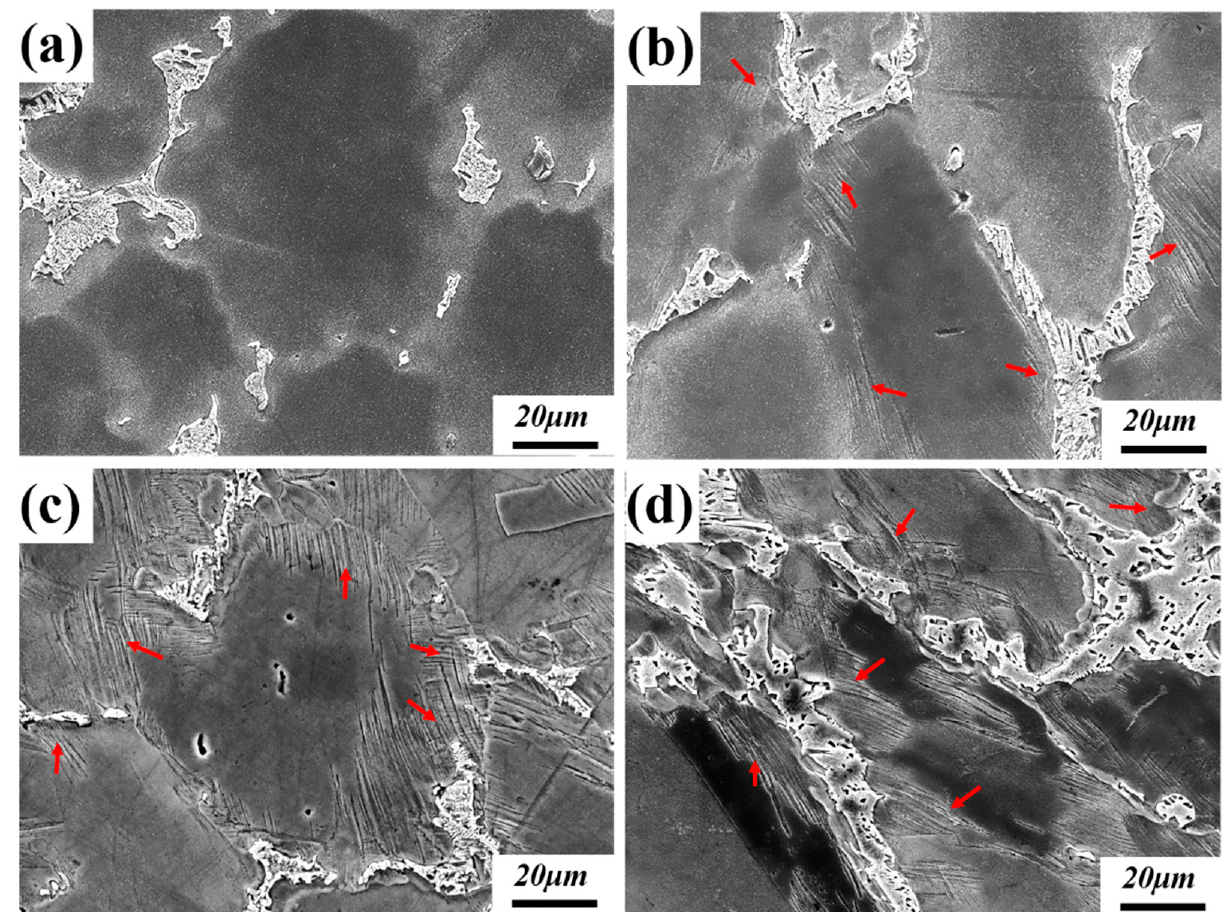
Figure 6. Microstructure of semi-solid CuSn10P1 alloy at a strain rate of 10 s − 1 and temperature of 350 ◦ C with different true strains (arrows indicate deformation marks): ( a ) ε = 0.0, ( b ) ε = 0.1, ( c ) ε = 0.2, ( d ) ε = 0.3.